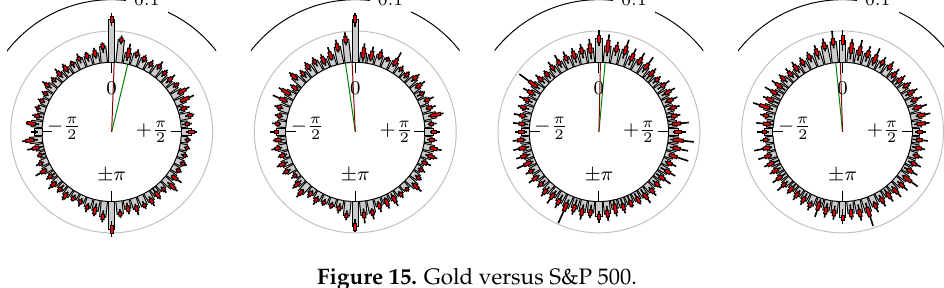
Figure 15. Gold versus S&P 500.